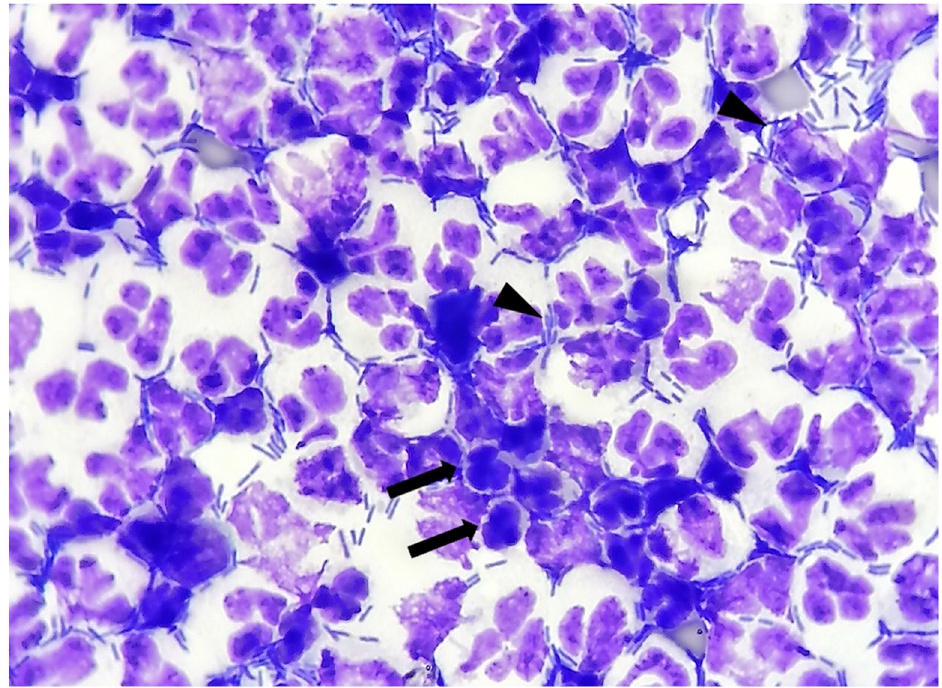
Figure 2. Canine urinary cytology performed after cytocentrifugation. Numerous neutrophilic degeneration details (arrows): nuclear swelling, karyolysis, pyknosis. Numerous rods are present, both extracellular and intracellular (arrow heads). (100× Oil).